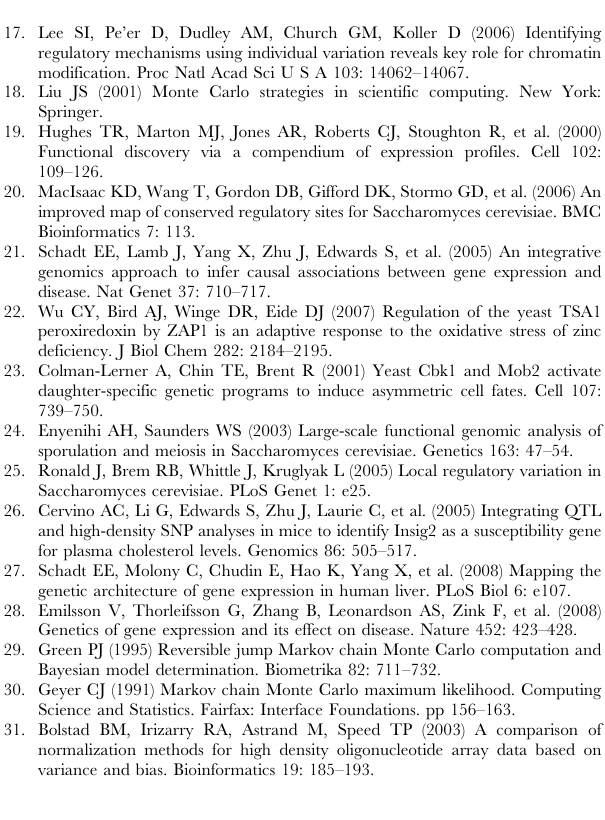
Figure S3 Plot of the causality test results for all pairs of genes between (A) module 4 and module 5 and (b) module 26 and 29. For a particular pair of genes (G1, G2) from module 4 and module 5, respectively, if the causality test claims that gene G1 is causal to gene G2 (corrected p-value , 0.05), i.e. G1 R G2, then a green dot is plotted at the corresponding position. Similarly, if the causality test results in G2 R G1, then a red dot is plotted at the corresponding position. Genes in module 4 and module 5 are sorted for better visualization. Similar procedure applies to (B). Figure S4 A local view of the coding sequence alignment of RM vs. BY for gene BPH1. The RM sequence has a deletion in the position labeled in red which results an in-frame stop. Figure S5 Trace plots and autocorrelation plots of the log posterior probabilities for one of the simulated data set ((A) and (B)) and the yeast data set analysis ((C) and (D)). In (A), the trace plot